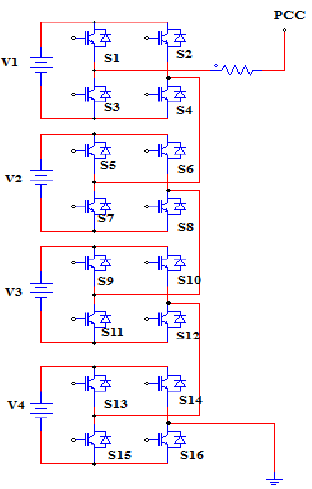
Figure 1. Traditional nine-level cascade inverter